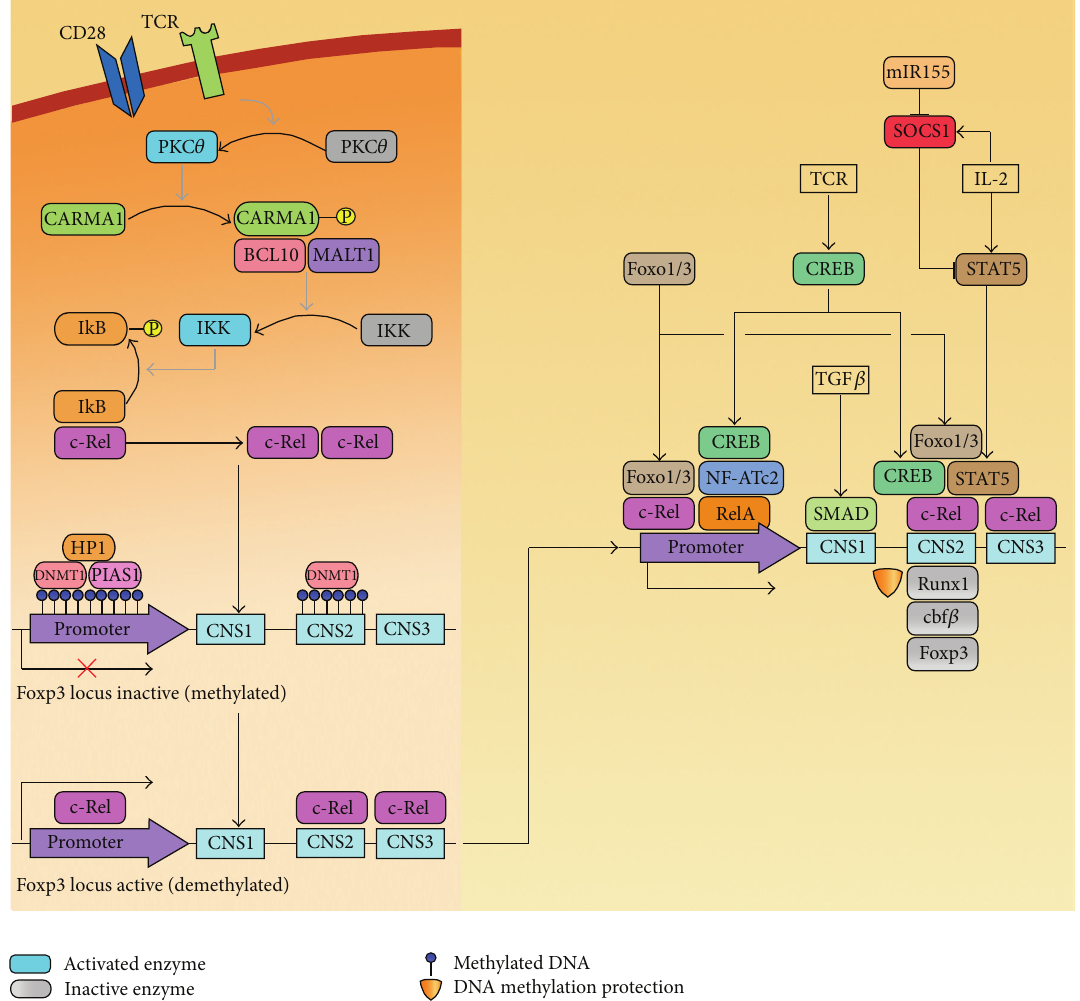
Figure 2: Transcription factors in tTreg development. Once engaged, cell surface receptors initiate c-Rel activation and nuclear entry. c-Rel binding to the Foxp3 promoter and Cns elements promotes epigenetic changes, including demethylation and chromatin remodelling (not pictured) of the Foxp3 locus. Several other transcription factors cooperate with c-Rel to initiate and preserve the stable expression of Foxp3 in